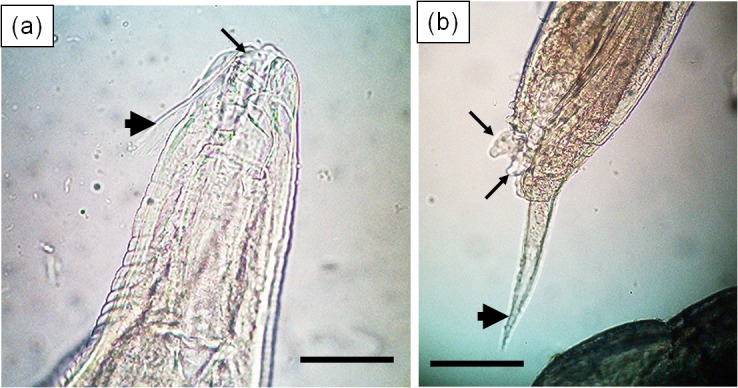
Photomicrographs of a male Labiduris sp. nematode detected in a Galápagos giant tortoise faecal sample.Scale bars = 50 μm. (a) Anterior end showing the subventral lips (arrow) with a posteriorly-directed fringe along the median edge (arrowhead). (b) Posterior end showing terminal appendix (arrowhead) and ventro-lateral papillae (arrows).